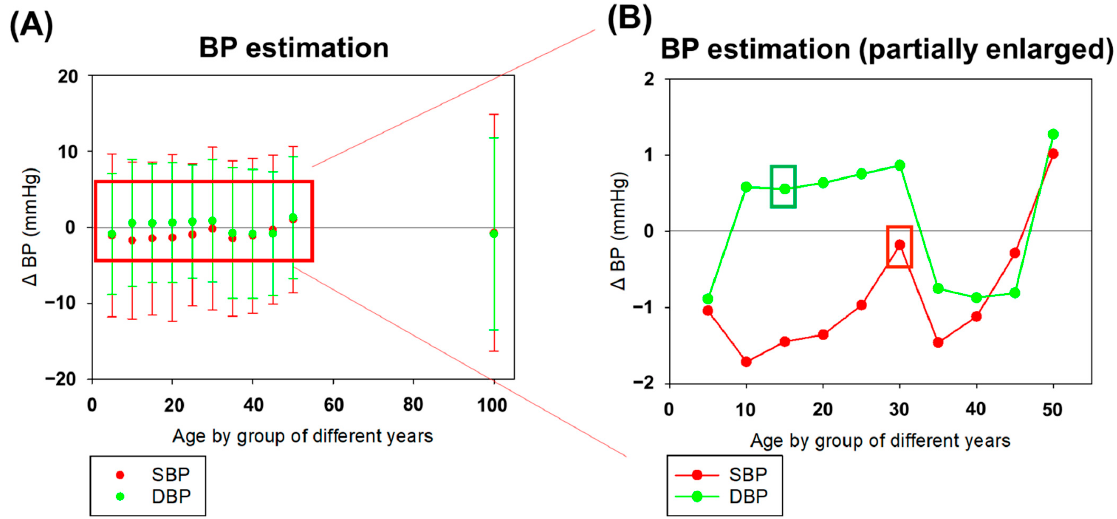
Figure 8. The estimation error of BP ( ∆ BP) with various periods of grouping years (5–50 years) and without grouping (100 years) in the exponential GPR model. ( A ) The ∆ BP and its standard deviation in SBP and DBP. The red line represented SBP results and the green line represented DBP results. ( B ) The partial enlarged detail of ∆ BPs of SBP and DBP for grouping the period of 5, 10, 15, 20, 25, 30, 35, 40, 45, 50 years. We found the period of 30 years for grouping had the lowest ∆ BP in SBP and the 15-year grouping had the lowest ∆ BP in DBP. All correlation results were similar with statistical significance ( p <